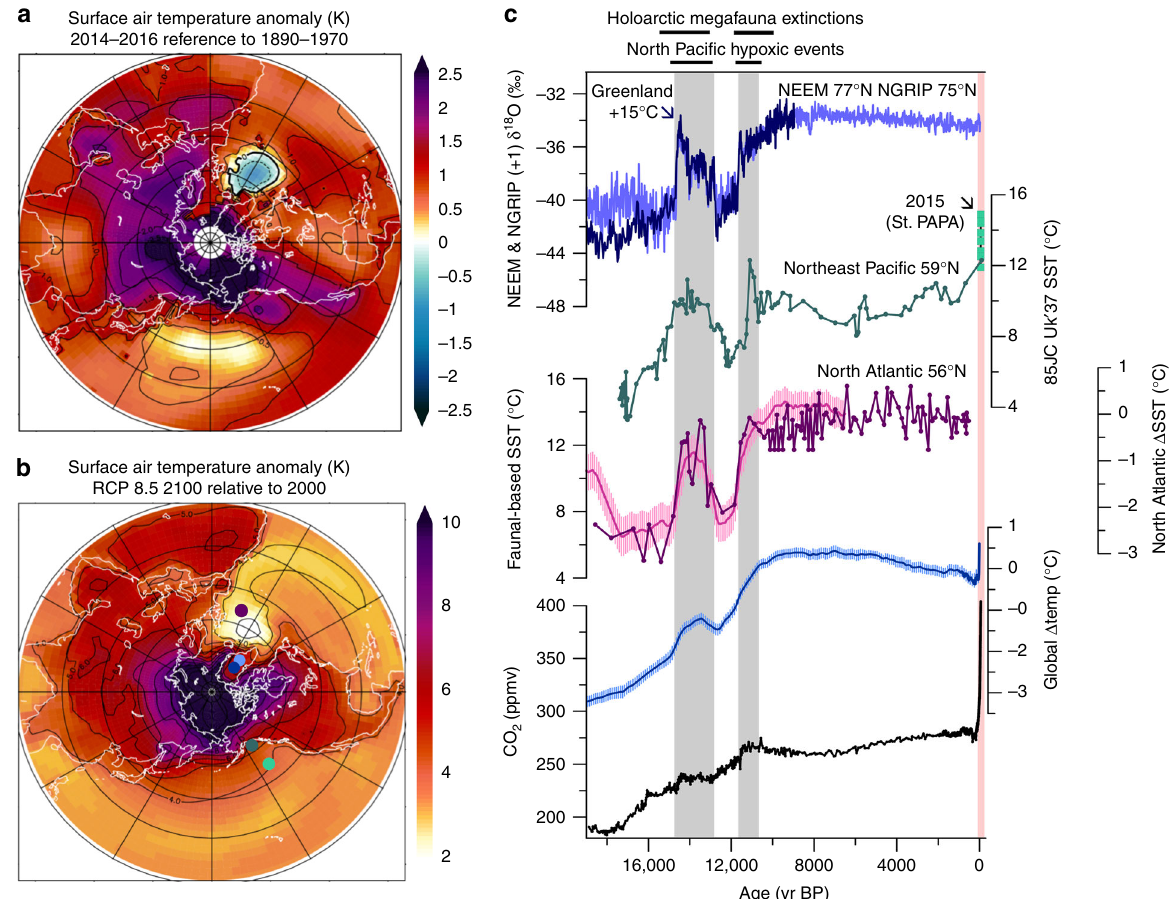
Fig. 1 Recent and projected surface air temperatures in context of past abrupt warming events in the northern hemisphere. Recent annual surface air temperature (SAT) anomalies for 2014 – 2016 relative to 1890 – 1970 ( a ; refs. 58,59 ), CMIP5 projected SAT anomalies by the end of the century in RCP 8.5 ( b ), and paleoclimate records spanning the past 19,000 years that document abrupt Arctic warming in concert with abrupt warming in the mid-latitude North Paci fi c and North Atlantic basins ( c ). Colored dots on map in b represent the locations for the paleoclimate datasets plotted in c . Record-breaking Arctic warming in recent years was associated with anomalously high SSTs in the Northeast Paci fi c despite a cold spot in the North Atlantic ( a ). Projected SATs show an ampli fi ed response in the Arctic and North Paci fi c, whereas North Atlantic SSTs undergo relatively modest warming in the fi rst century ( b ). c Paleoclimate archives spanning the last 19,050 years (1950 = year 0). From top: Greenland δ 18 O records from NEEM 19,000 – 10,000 years ago (dark blue 26 ) and NGRIP (light blue 60 ), An alkenone-based UK ’ 37 SST reconstruction from the Gulf of Alaska re fl ecting Summer SST (dark green 22 ); the youngest data point represents the core top measurement taken in 2004 (ref. 61 ); September SST data from Ocean Station Papa (145°W, 50°N) from 2007 to 2015 are plotted on the same axis (light green squares; http://www.pmel.noaa.gov/ocs/data). An SST reconstruction based on faunal assemblages from the central North Atlantic (plum 24 ), and a reconstruction of the average North Atlantic SST anomaly relative to Holocene values (pink 25 ). A composite record of the global temperature anomaly for the past 20,000 years relative to the 1980 – 2004 mean (blue 25,62,63 ). Atmospheric CO 2 concentrations from 19,000 years ago to present based on ice cores measurement and modern measurements 64 . Gray shaded bars represent two episodes of rapid warming in Greenland that are coeval (within age uncertainties) with abrupt SST increase in the Northeast Paci fi c and North Atlantic, increases in CO 2 concentration, and intervals of widespread hypoxia in the North Paci fi c 22,28 and Holarctic megafauna extinctions 29 . Pink bar